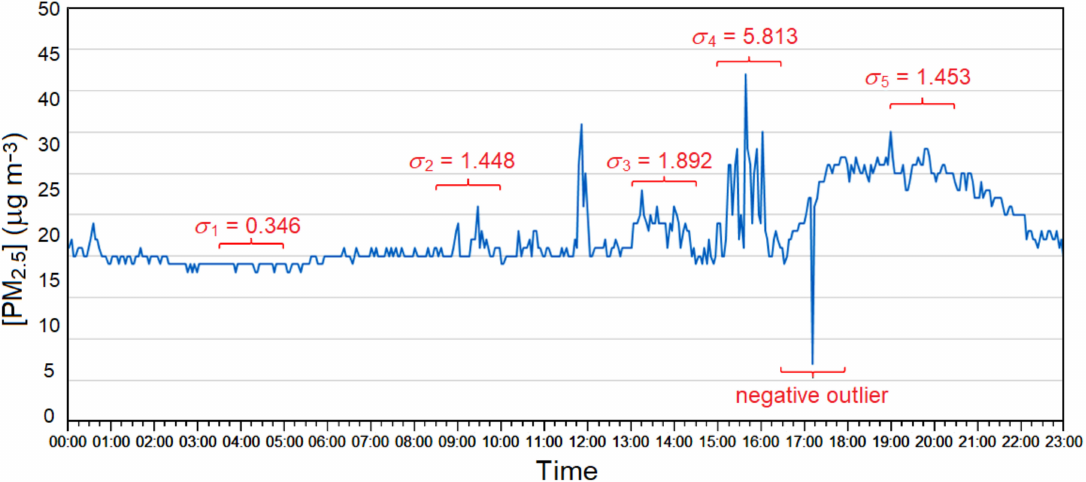
Figure 13. Monitoring curve of No.: 1858224692 SAQ-200 sensor on 1 January